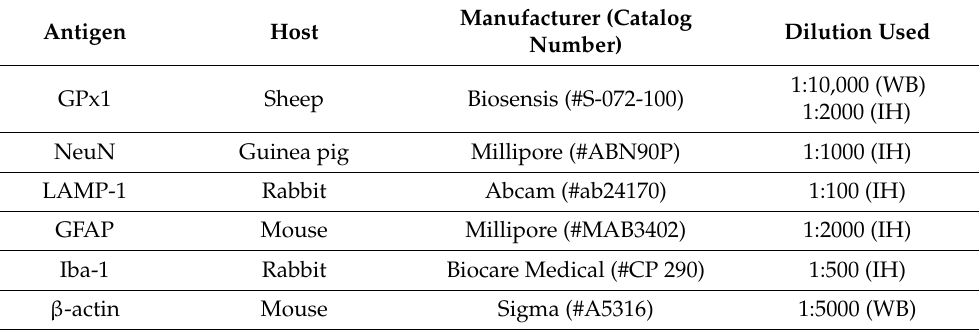
Table 1. Primary antibodies used in the present